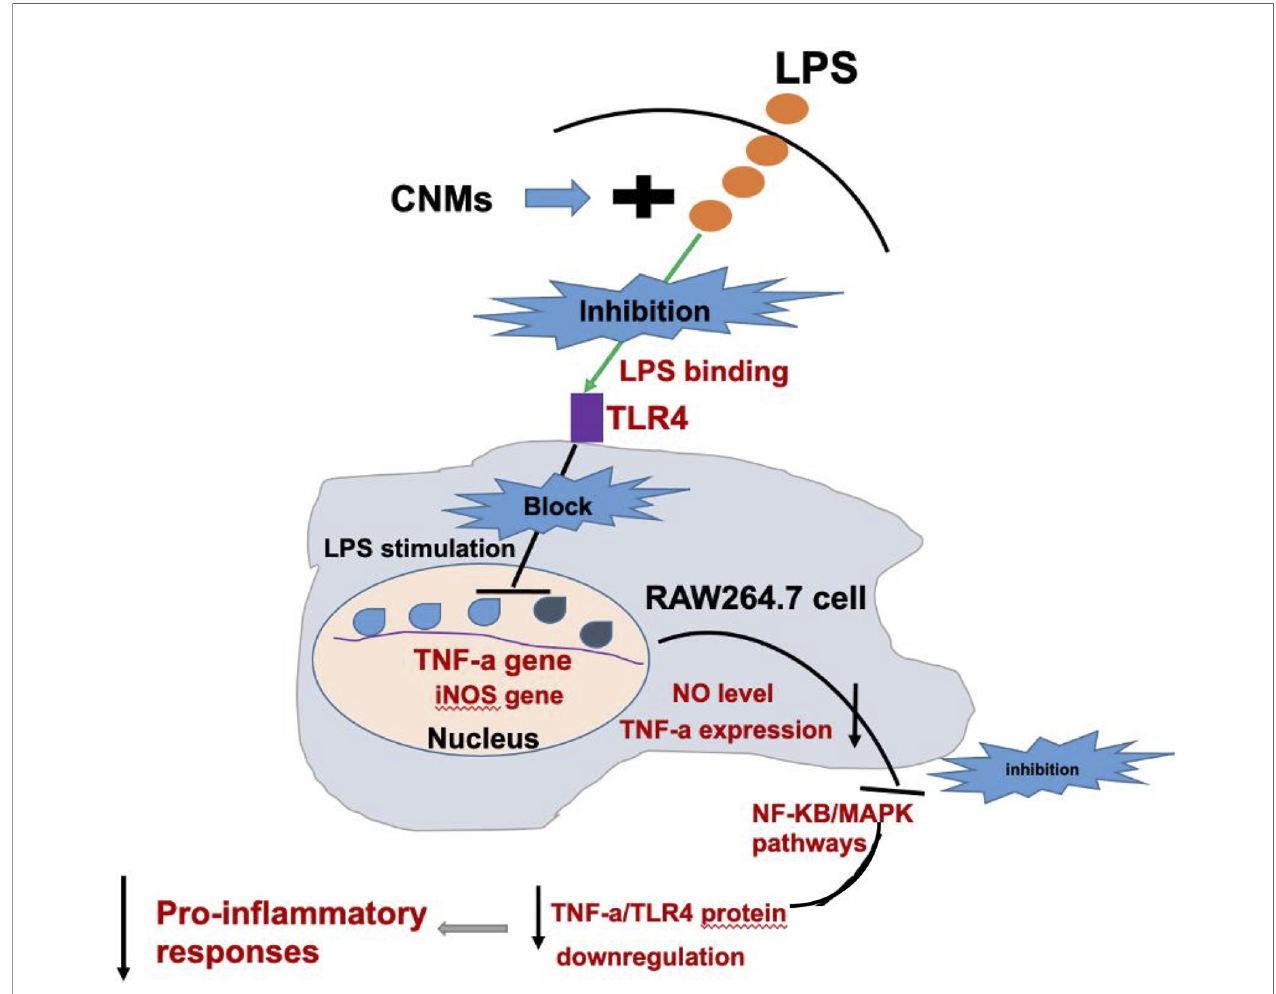
FIGURE 7 | Schematic diagram of a potential mechanism by which CNMs suppress LPS-induced in fl ammatory